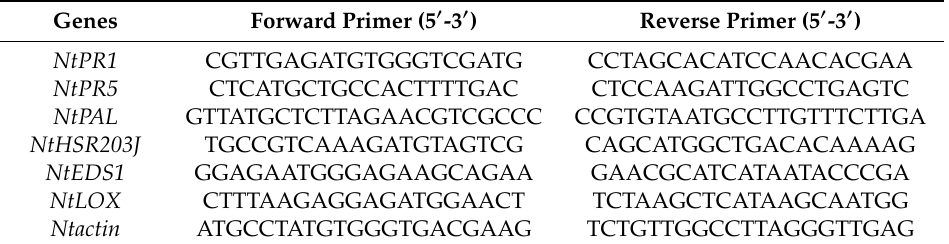
Primers used for quantitative real-time polymerase chain reaction (qRT-PCR) of pathogenesis-related